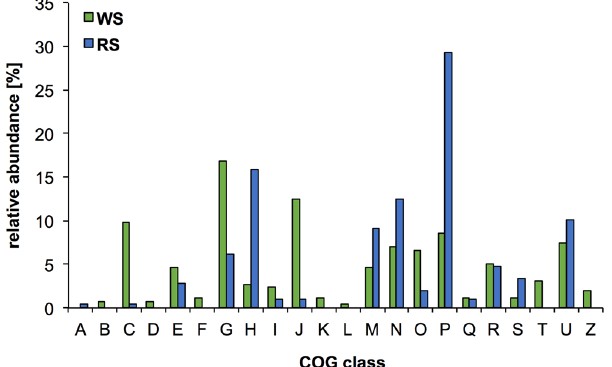
Figure 5. Comparison of clusters of orthologous groups (COGs) in metasecretome of wheat straw (WS) and rice straw (RS) compost derived communities. The predicted proteins identified in metasecretome were mapped to different COGs using WebMGA server and RPSBLAST program. [A] RNA processing and modification [B] Chromatin structure and dynamics [C] Energy production and conversion [D] Cell cycle control, cell division, chromosome partitioning [E] Amino acid transport and metabolism [F] Nucleotide transport and metabolism [G] Carbohydrate transport and metabolism [H] Coenzyme transport and metabolism [I] Lipid transport and metabolism [J] Translation, ribosomal structure and biogenesis [K] Transcription [L] Replication, recombination and repair [M] Cell wall/membrane/envelope biogenesis [N] Cell motility [O] Post-translational modification, protein turnover, and chaperones [P] Inorganic ion transport and metabolism [Q] Secondary metabolites biosynthesis, transport, and catabolism [R] General function prediction only [S] Function unknown [T] Signal transduction mechanisms [U] Intracellular trafficking, secretion, and vesicular transport [Z]